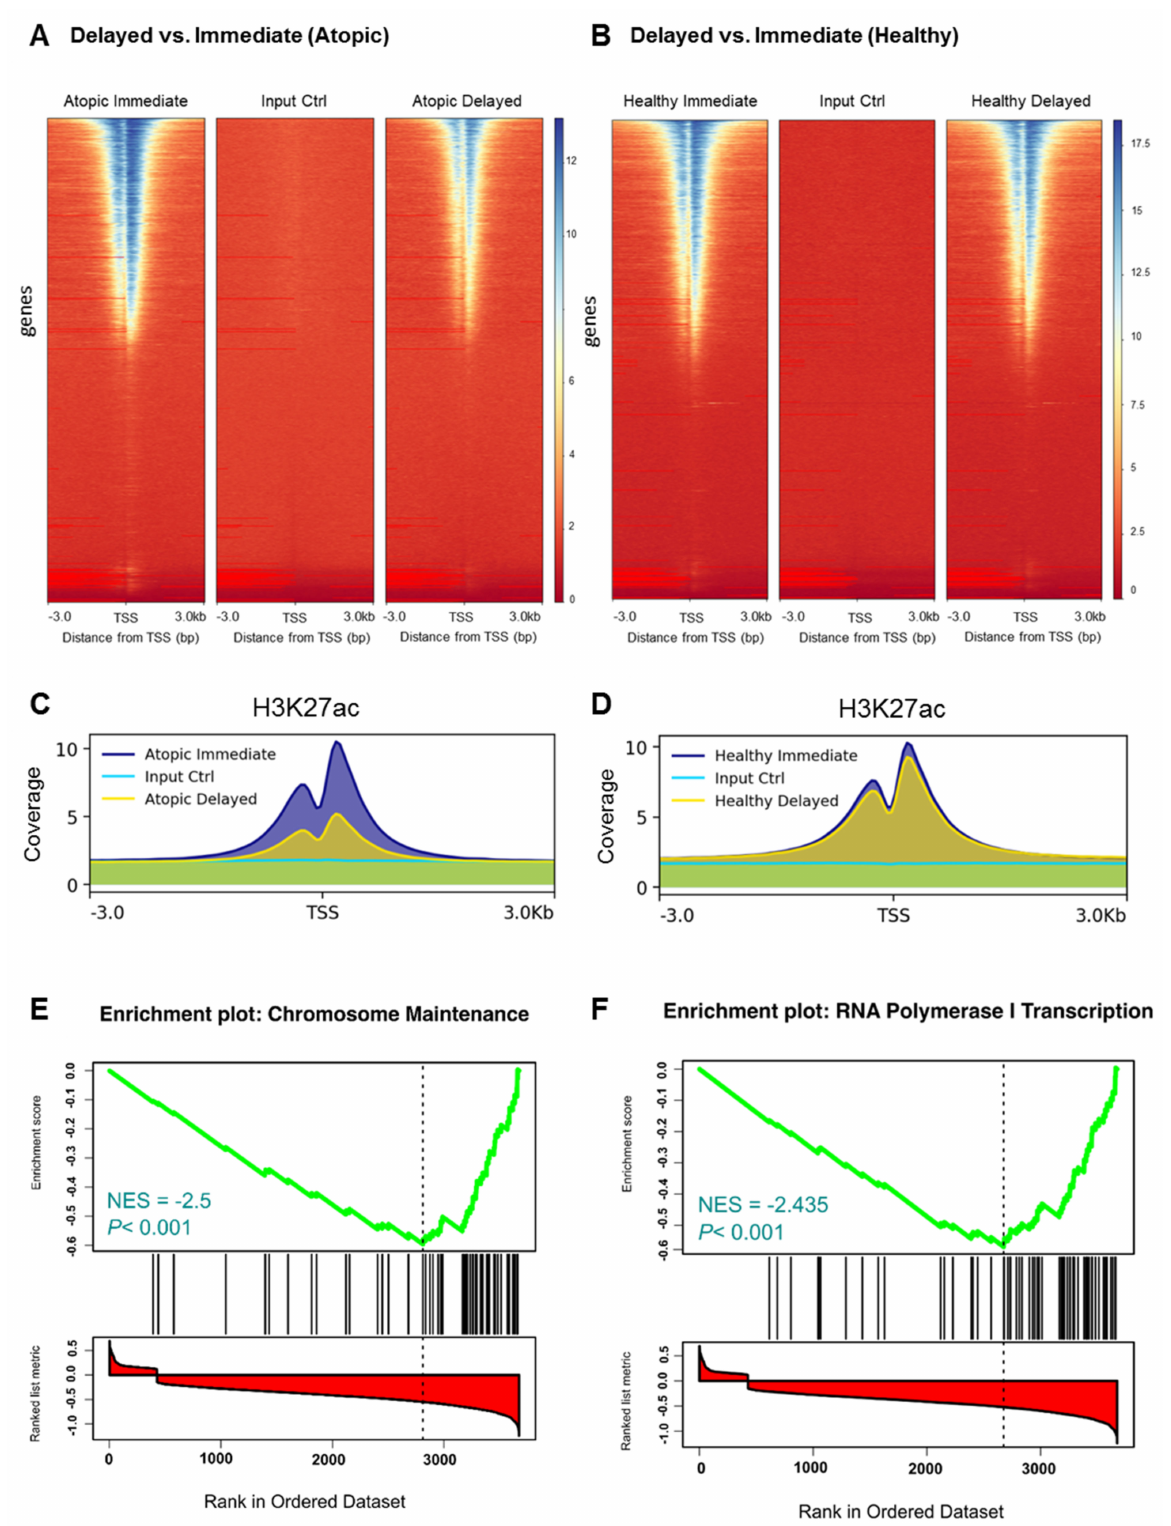
Figure 4. Selective histone modification changes within immediately versus delayed processed CD4 + T-cells from atopic subjects. ( A , B ) Genomic heatmaps visualizing H3K27 acetylation ChIP-Seq analyses scores associated with genomic regions of 3 kilobases (kb) around the gene